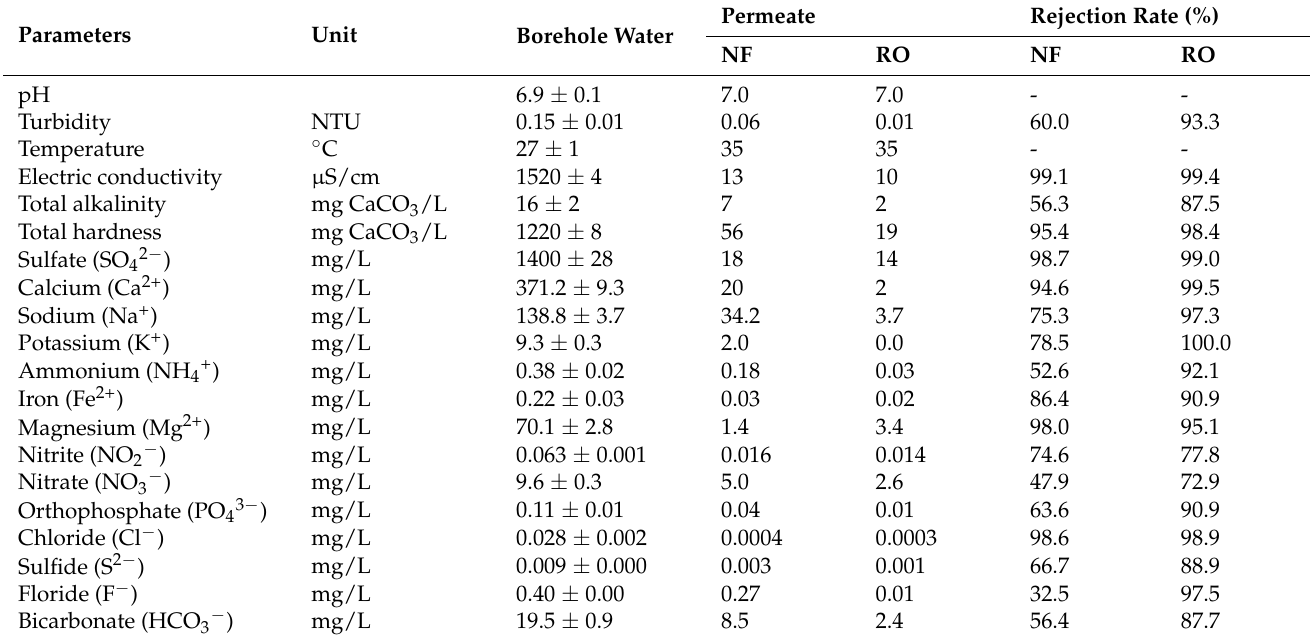
Table 3. Permeate characteristics and membrane